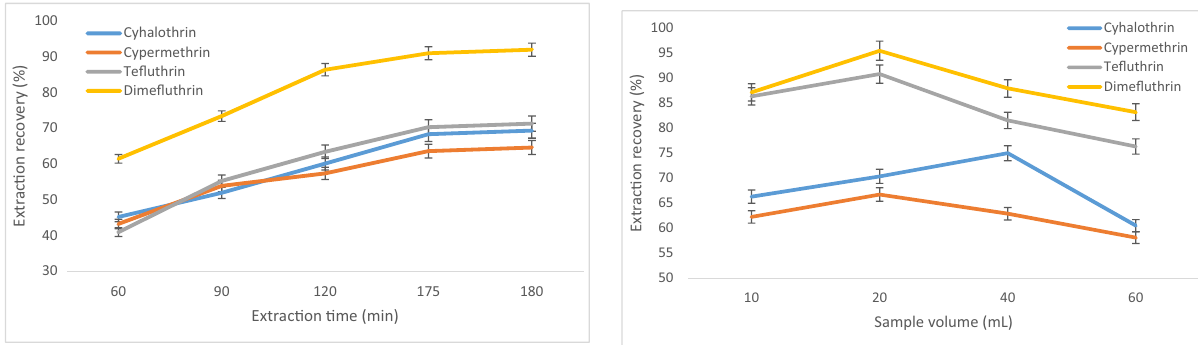
Figure 1: E ff ect of time on the e ffi ciency of extraction ( extraction conditions: 100 µL of 100 ng L − 1 of each analyte; stirring speed: 700 rpm; sample volume: 20 mL; temperature: 40°C; pH: 7 ) .